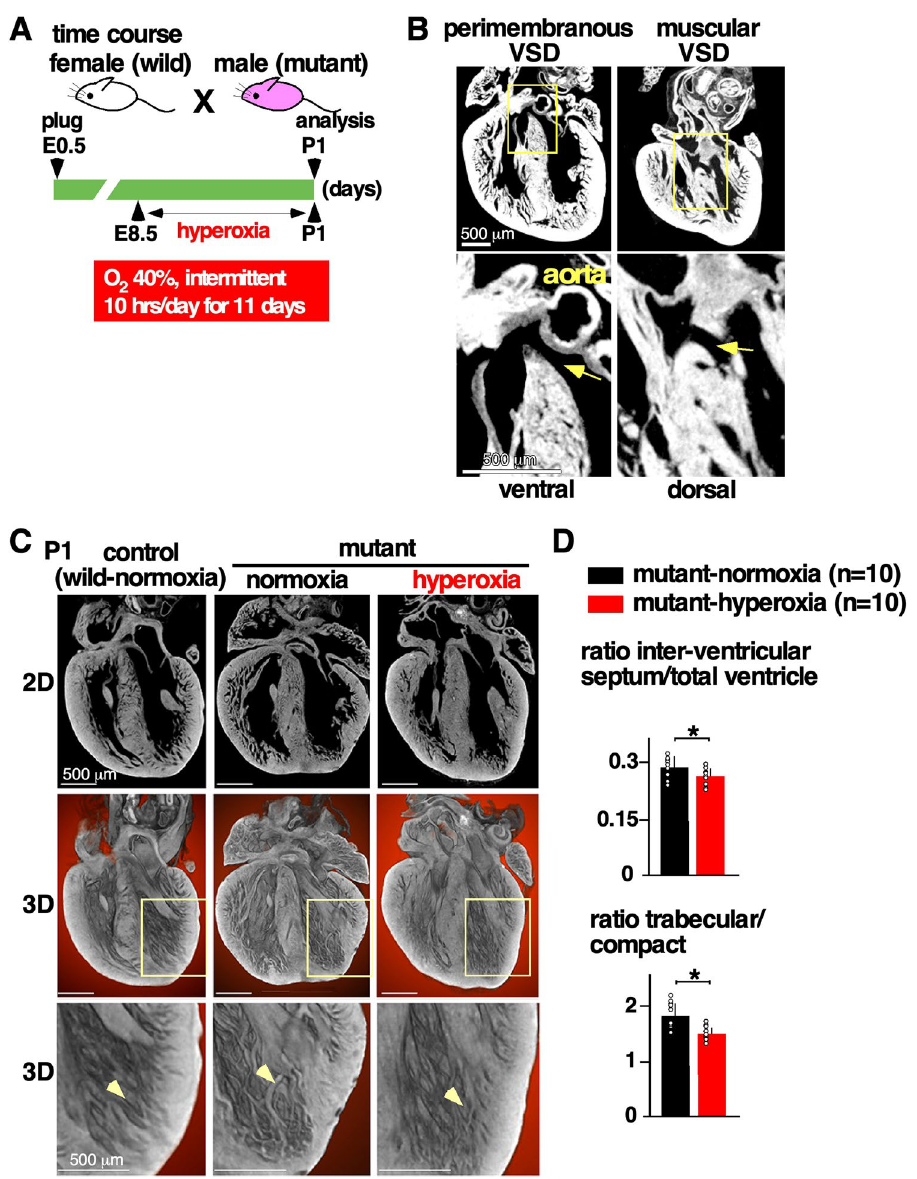
Figure 2. Experimental design of gestational hyperoxia (40% O 2 saturation) and representative images of postnatal day 1 Nkx2-5 mutant hearts using micro-computed tomography (CT). ( A ) Timeline of experiment. ( B ) Representative 2D images demonstrating perimembranous and muscular VSD regarding their location (arrows). ( C ) Representative 2D and 3D micro-CT images showing ventricular trabeculation (arrowheads). ( D ) Quantification of area size of total ventricle, inter-ventricular septum, trabecular and compact layers. Data are expressed as mean ± S.D.; individual data are represented as circles. The Shapiro–Wilk normality test confirmed normal distribution of variables. * P ≤ 0.05. VSD ventricular septal defect. ImageJ 1.52d (http:// imagej. nih. gov/ ij) was used for analysis.